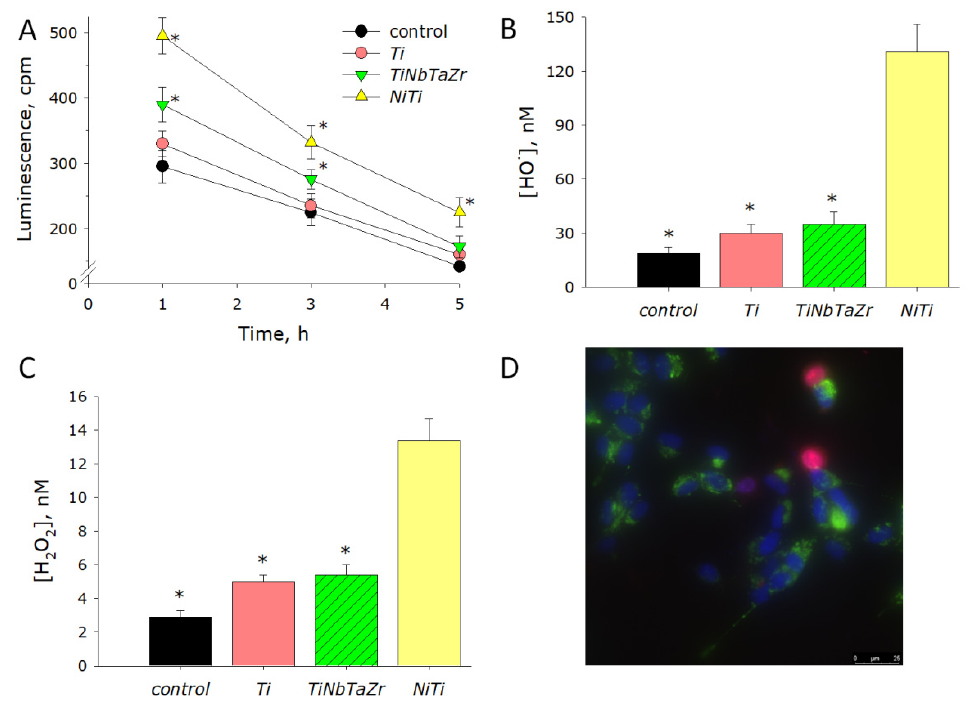
Figure 4. Effect of the Ti–25Nb–13Ta–5Zr alloy (TiNbTaZr) on the generation of long-lived reactive protein species and reactive oxygen species, compared to Ti, nitinol (NiTi) and a control. ( A ) Effect of Ti–25Nb–13Ta–5Zr on the formation of long-lived reactive protein species (2 h, 40 °C). ( B ) Effect of Ti–25Nb–13Ta–5Zr on the generation of hydroxyl radicals (2 h, 80 °C). ( C ) Effect of Ti–25Nb–13Ta–5Zr on the formation of hydrogen peroxide (2 h, 40 °C). ( D ) Microphotograph of a cell culture, obtained by an overlay of three fluorescent channels and transmitted light. Cytoplasm is colored green; cell nuclei are colored red in the state of apoptosis. Asterisks indicate a significant difference at the 5% level (Student’s unpaired t -test) in comparison with the control ( p < 0.05).